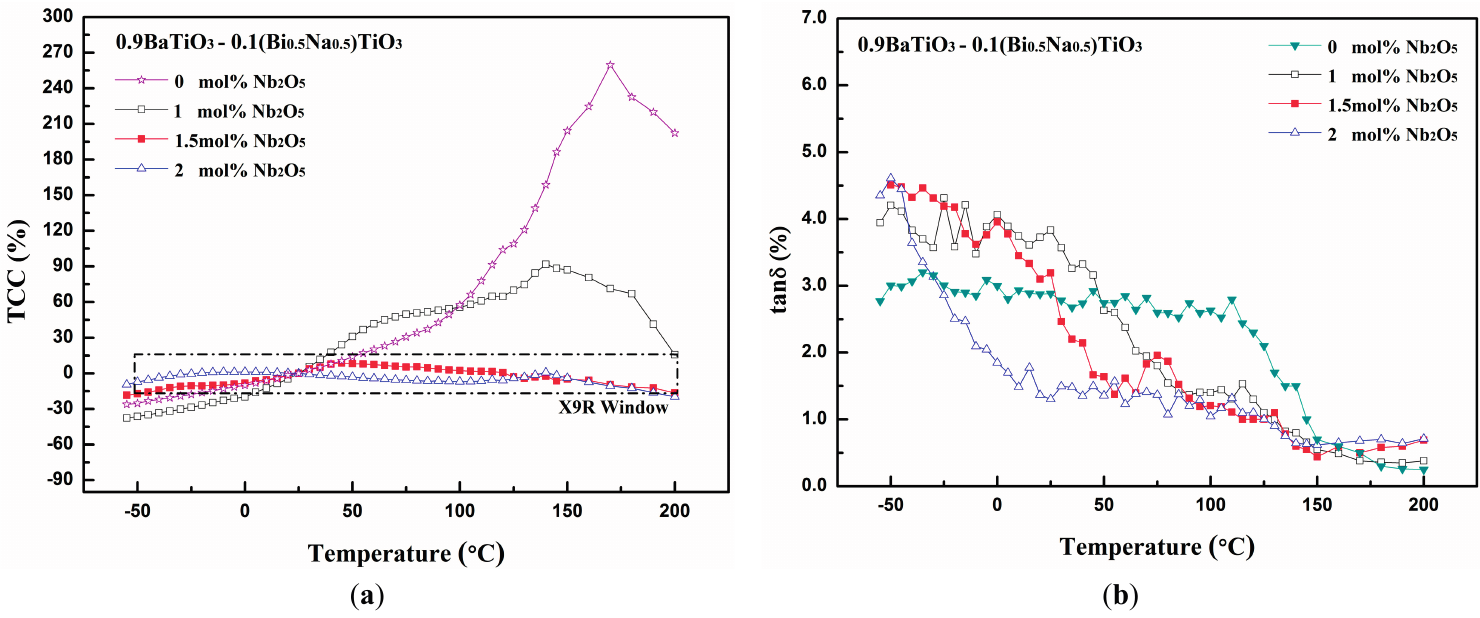
( a ) ( b ) Figure 5. ( a ) Temperature coefficients of capacitance and ( b ) dielectric losses versus temperature of 0.9BaTiO 3 –0.1(Bi 0.5 Na 0.5 )TiO 3 ceramics with addition of various amounts of Nb 2 O 5 sintered at 1215 °C (measured frequency = 1 kHz; heating rate = 2 °C/min; applied voltage = 1 V). Table 2. Dielectric properties of 0.9BaTiO 3 –0.1(Bi 0.5 Na 0.5 )TiO 3 ceramic with various amounts of Ta 2 O 5 and Nb 2 O 5 at their maximum sintered densities. Additives Sintering Condition (°C/